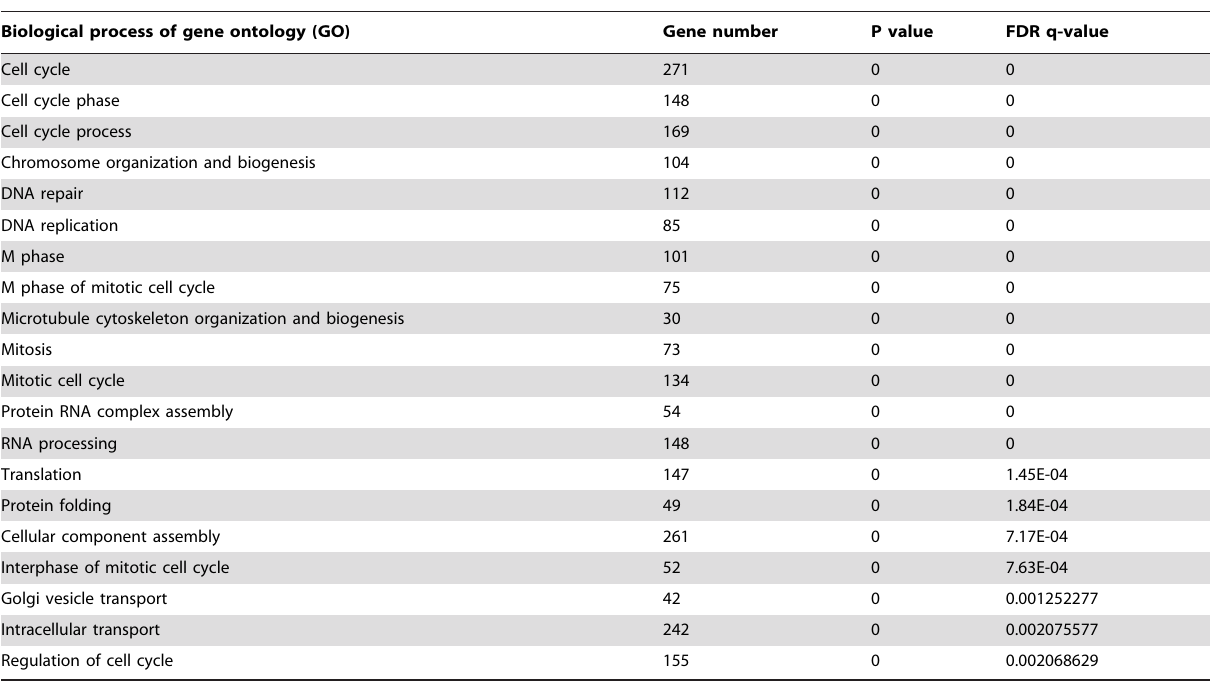
Table 1. Biological processes and pathways associated with B-MYB deficiency.